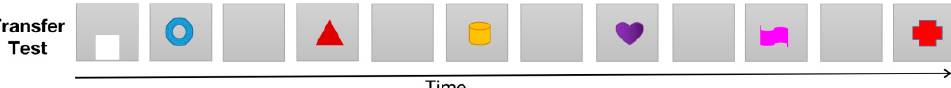
Figure 2. Transfer task protocol. After the monkey had learned the 1-to-6 task, all stimulus patterns at any ordinal position varied randomly in size, color, and shape. The monkeys were required to touch the 6th pattern, inhibiting any response to patterns appearing at other ordinal positions.